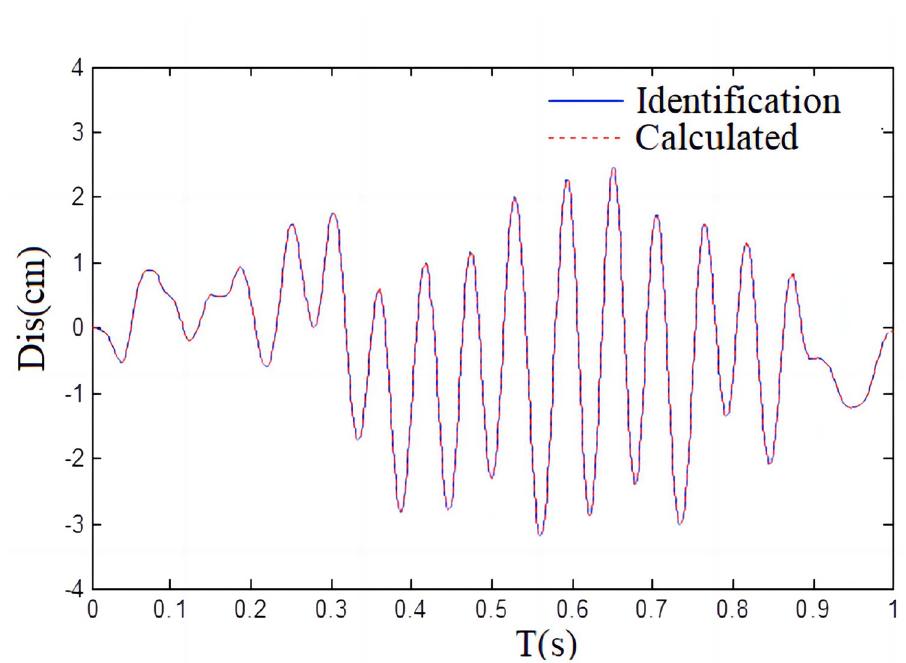
Fig 10. Identification and comparison of simulation curves. (a) Quality recognition and calculated simulation results; (b) Damp recognition and calculated simulation results; (c) Stiffness recognition and calculated simulation results.